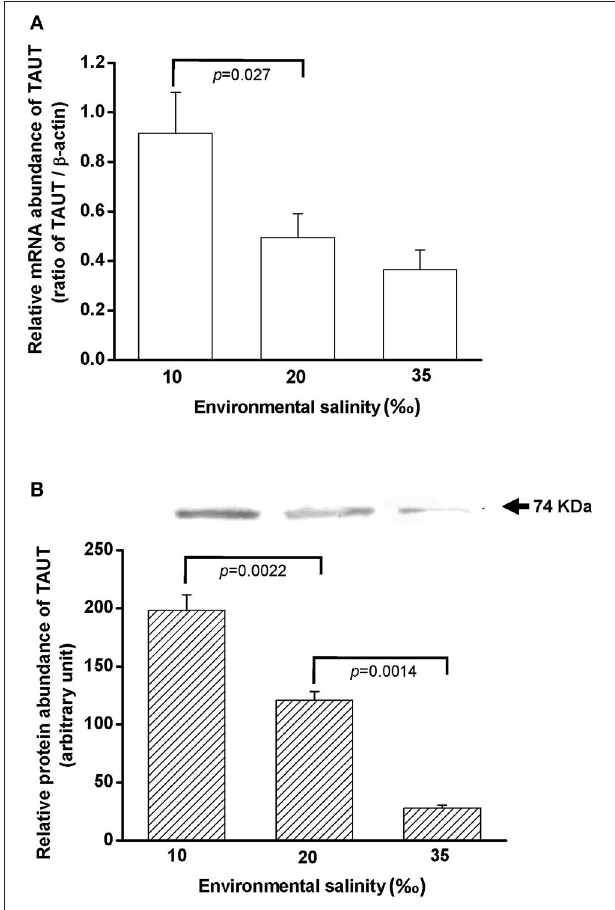
FIGURE 7 | Salinity effects on TAUT mRNA (A) and protein expression (B) in gills of the hard clam. The representative immunoblot for the protein expression was shown in (B) . Statistical analysis was performed with one-way ANOVA followed by Dunnett’s test. The 20 ‰ SW group was used as a control. p < 0.05 was considered statistically significant. Values are means ± SEM. ( N =